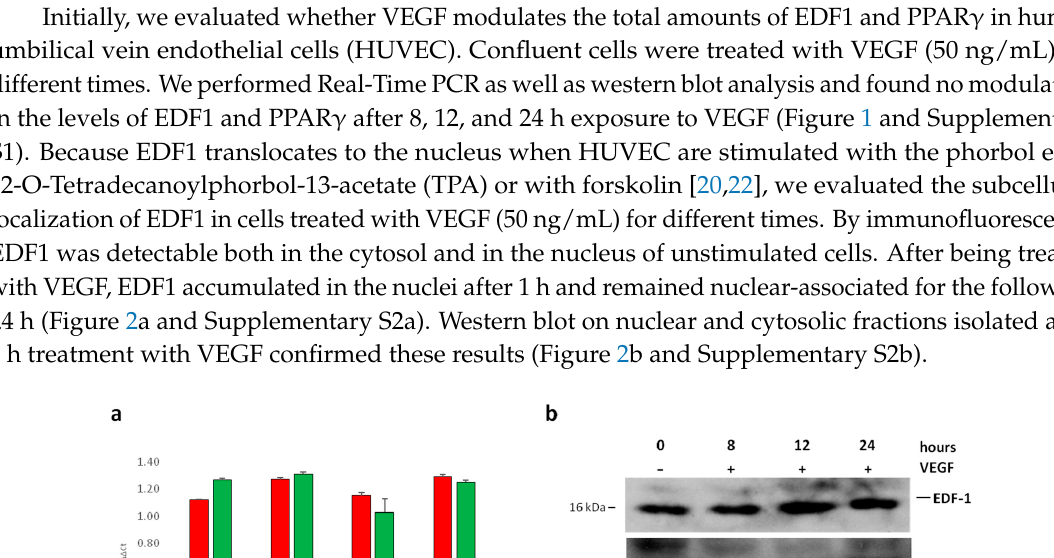
Figure 2. Subcellular localization of EDF1 in cells treated with VEGF. ( a ) HUVEC were treated with VEGF (50 ng/mL) for 1, 8, 12, and 24 h. Immunofluorescence was performed using anti-EDF1 immunopurified immunoglobulin G (IgGs) and rhodamine-conjugated anti-rabbit IgGs; ( b ) HUVEC were treated with VEGF (50 ng/mL) for 1 h. Western blot was performed on nuclear and cytosolic fractions using antibodies against EDF1. GAPDH and TBP were used as cytosolic and nuclear markers, respectively. A representative blot is shown. 2.2. Interaction between EDF1 and PPAR γ in HUVEC We evaluated the interaction between EDF1 and PPAR γ in HUVEC treated with VEGF (50 ng/mL) for various times. Cell lysates were immunoprecipitated with antibodies against PPAR γ . Western blot was performed on the immunoprecipitates to detect EDF1. EDF1 and PPAR γ interacted in nonstimulated cells and VEGF did not significantly modulate this interaction at the time points tested (Figure 3 and Supplementary S3).